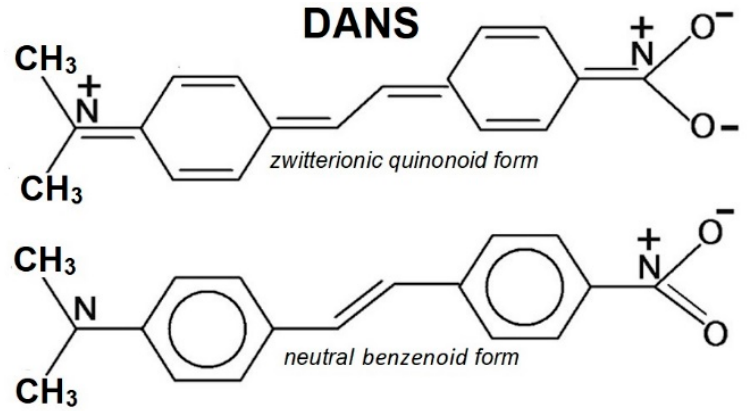
Figure 10. Resonance structures of DANS.